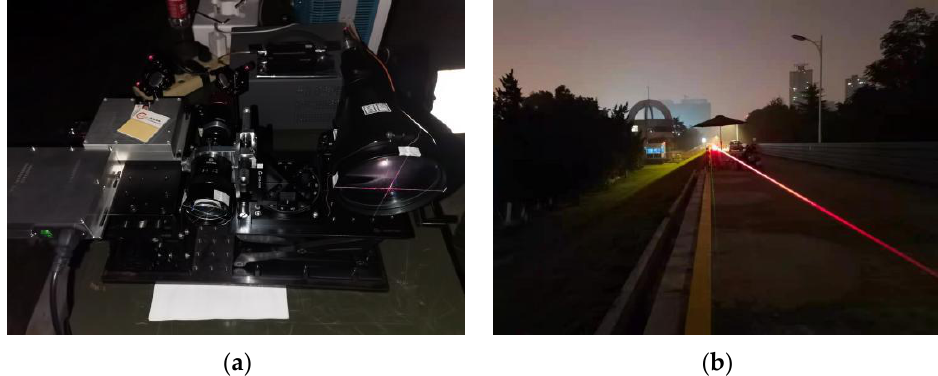
Figure 2. Experimental platform. ( a ) The laser transmitter and ( b ) the outfield experiment environment.